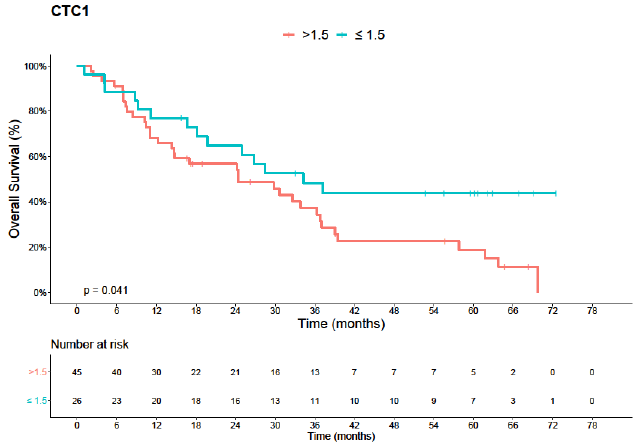
Figure 1. Kaplan–Meier curves of overall survival in the general studied population (75 patients with metastatic colorectal cancer). In blue, survival curve for patent with ≤1.5 CTC/mL. In red, patients with >1.5 CTC/mL ( p = 0.041). Table 2. Estimate of the parameters of the simple and multiple Cox regression model for overall survival from metastatic colon cancer.